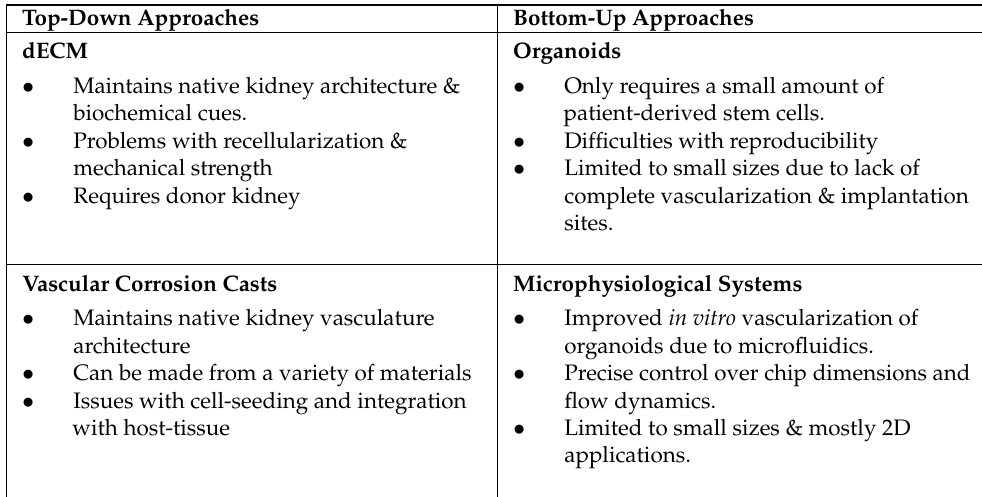
Table 1. Comparison of developments and limitations of top-down and bottom-up approaches discussed in this